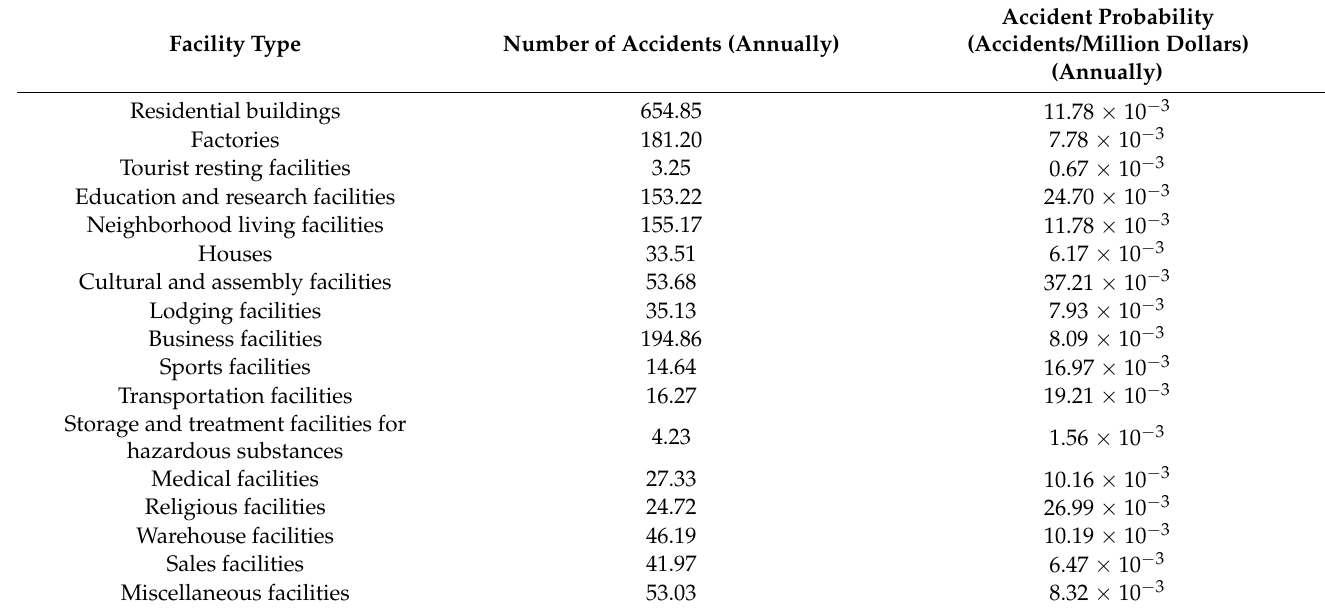
Table 4. Analysis of accident probability for 17 facility types using Bayesian